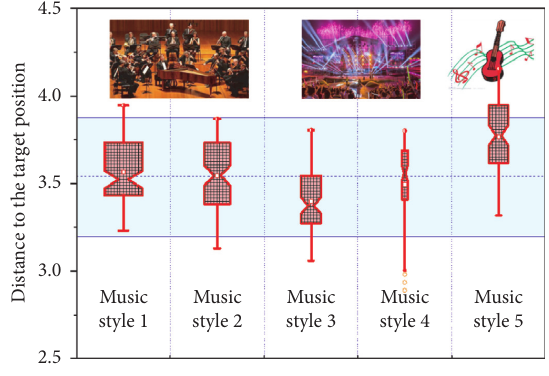
Figure 4: Distance to the target